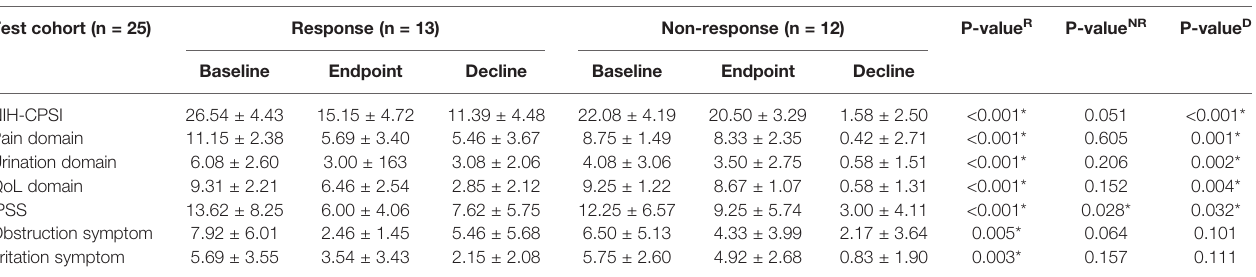
TABLE 3 | Scores of NIH-CPSI, IPSS, and their subgroup in testing cohort. Test cohort (n =